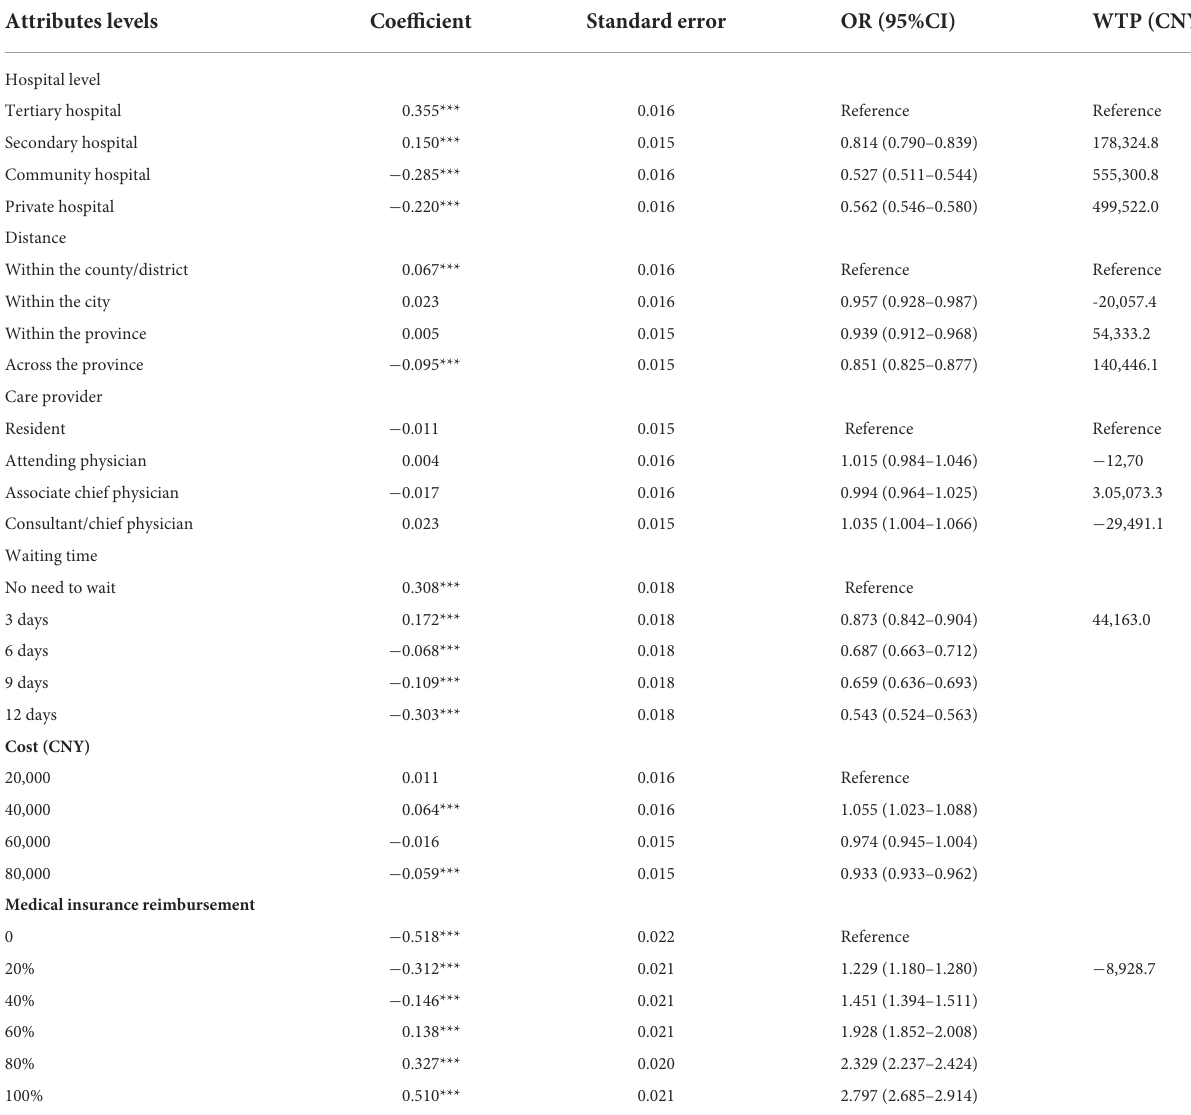
TABLE 6 Attributes and levels of major diseases